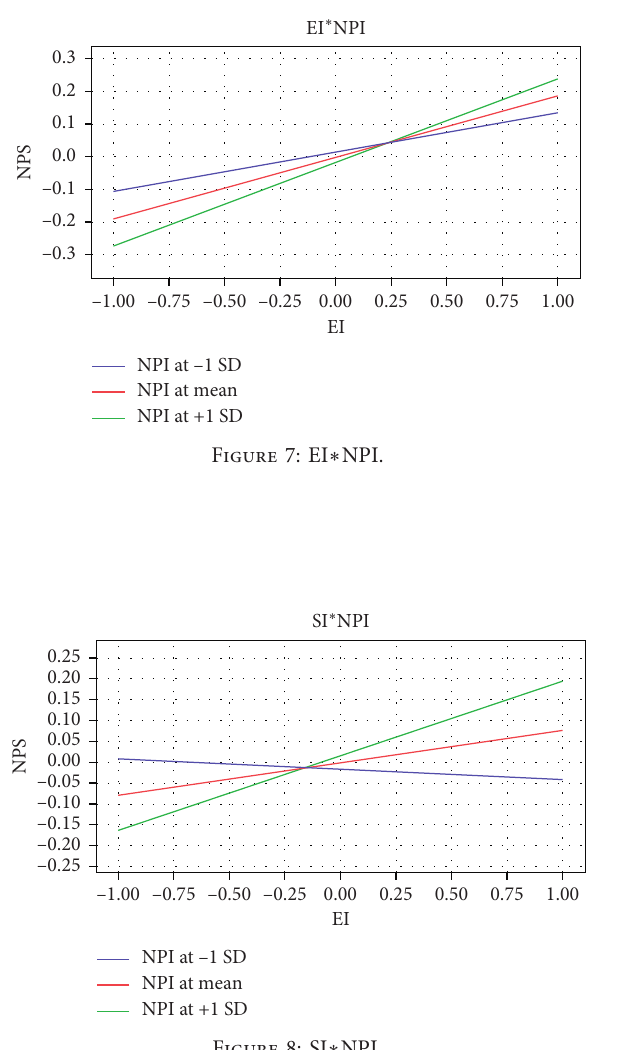
Figure 8: SI ∗ NPI.